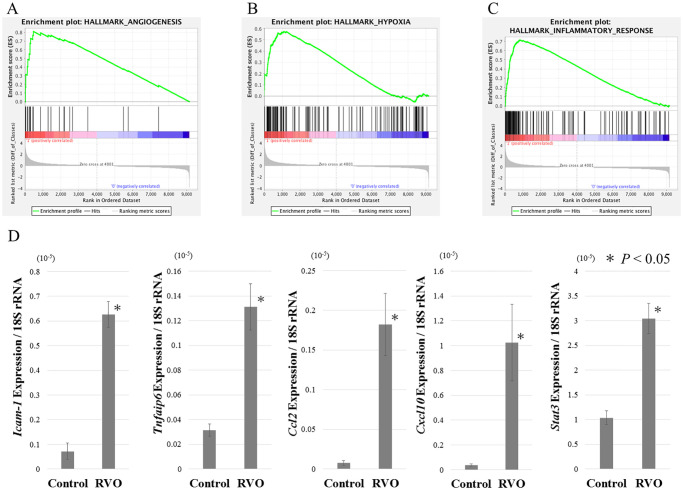
Enrichment plots of remarkable gene sets.Hypoxia, angiogenesis, and inflammatory pathways were significantly upregulated in RVO retinas. Plots are shown for (A) angiogenesis, (B) hypoxia, and (C) inflammatory response gene sets. (D) RT-qPCR result on days 7 after RVO induction. Tnfaip6, Icam-1, Ccl2, Cxcl10, Stat3 expressions were significantly increased in RVO retinas compared to control retina. RT-qPCR results were normalized to 18S rRNA expression. Data are expressed as mean ± SE (n = 3). (* P < 0.05, RVO versus control retina.).